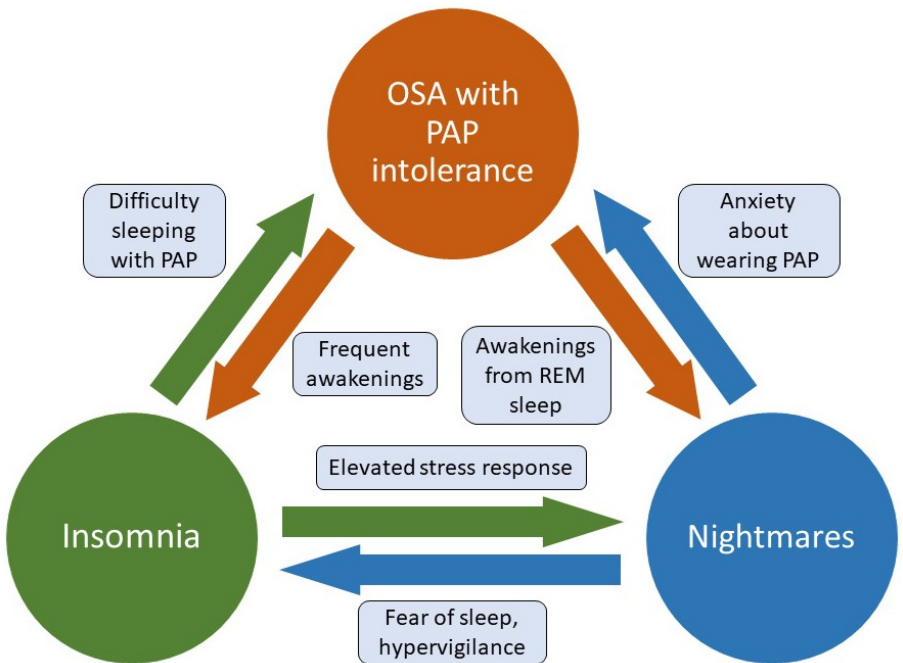
Figure 1. Factors contributing to untreated OSA, insomnia, and nightmares in PTSD sufferers. Un- treated sleep apnea may lead to frequent awakenings which precipitate and/or perpetuate insomnia, as well as arousals from REM sleep leading to increased nightmare intensity and recall. Difficulty initiating and maintaining sleep interferes with the ability to tolerate PAP therapy, and hyperarousal related to insomnia may increase nightmares via elevated stress response during REM sleep. The presence of nightmares often leads to fear of sleep, hypervigilance, and poor sleep hygiene (e.g., leaving lights on) that worsen insomnia. Nightmares may also reduce PAP tolerance due to increased anxiety and hypervigilance. OSA, obstructive sleep apnea. PAP, positive airway pressure. REM, rapid eye